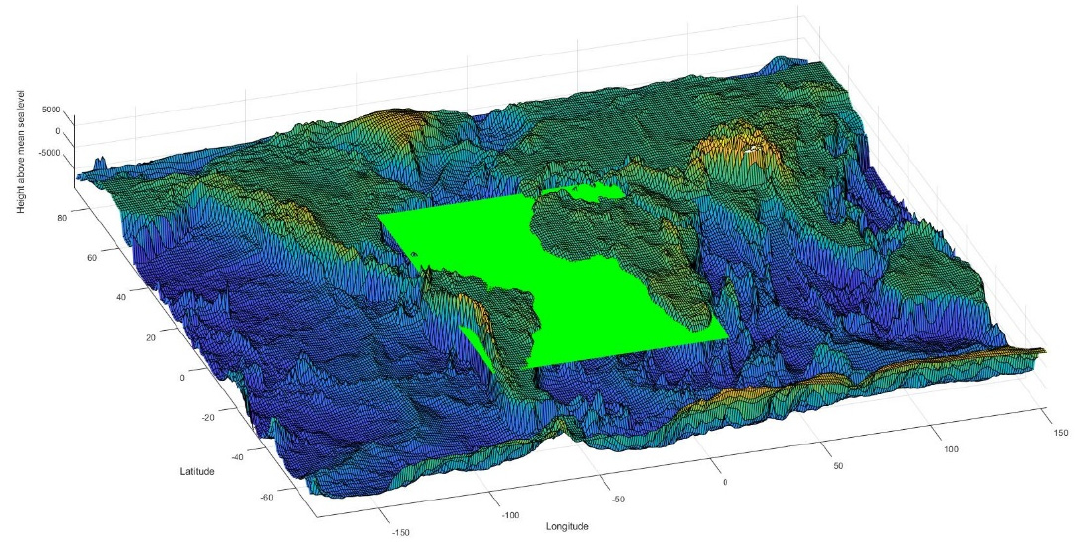
Figure 3. Example of navigable points of the route matrix.